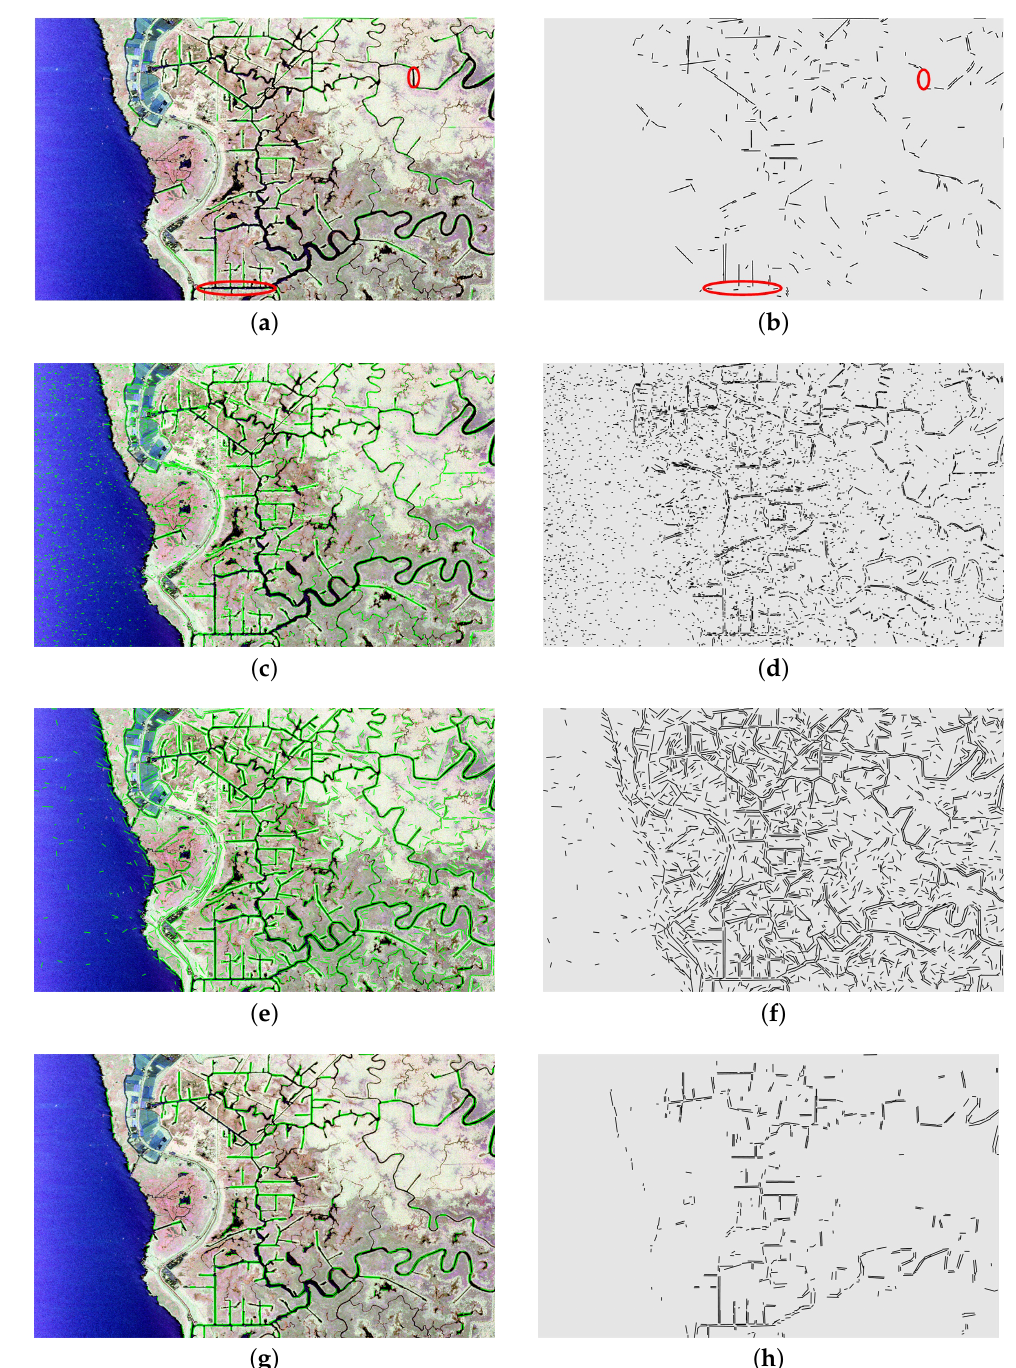
Figure 10. Line segment detection results of different methods in complex scenarios. ( a , b ) LSD. ( c , d ) Linelet-LSD. ( e , f ) LSDSAR. ( g , h ) PLSD. Red circle: obvious line areas missed in the